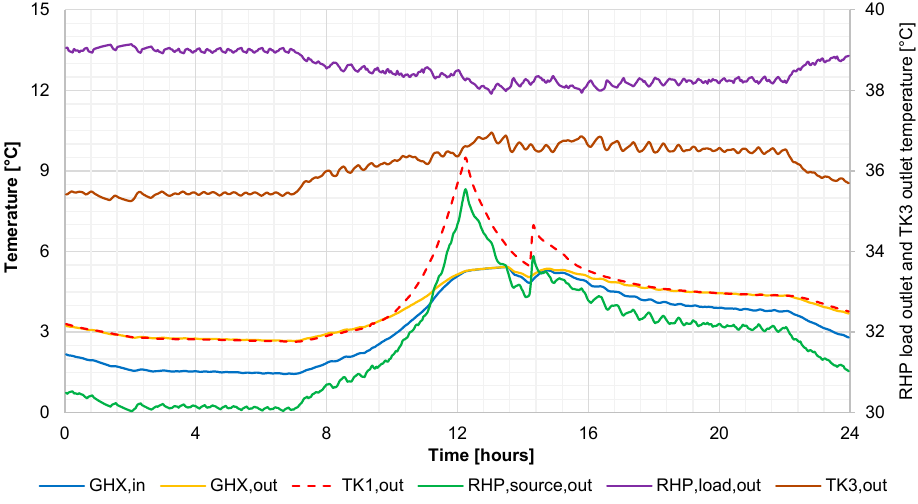
Figure 5. Main temperatures of GHX, TK1, RHP and TK3, daily analysis, winter day.